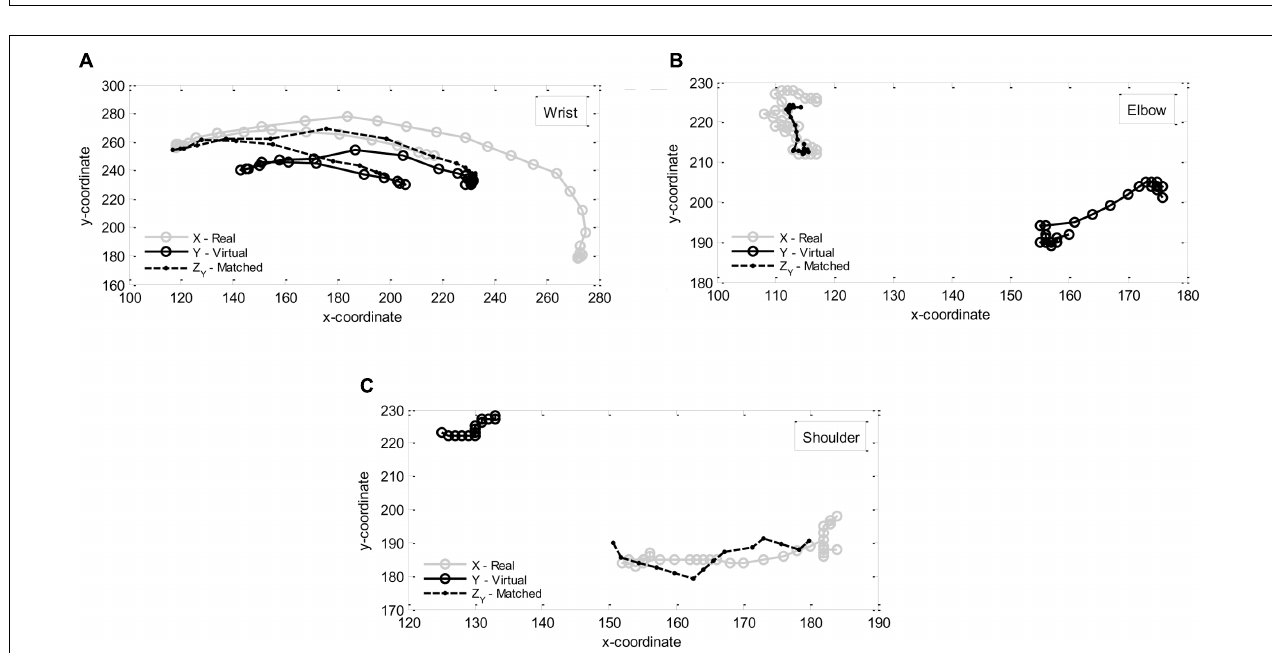
FIGURE 2 | Procrustes method for movement trajectories of participant S0 in real and virtual scenarios regarding: (A) the wrist, (B) the elbow, (C) the shoulder in trial 3.